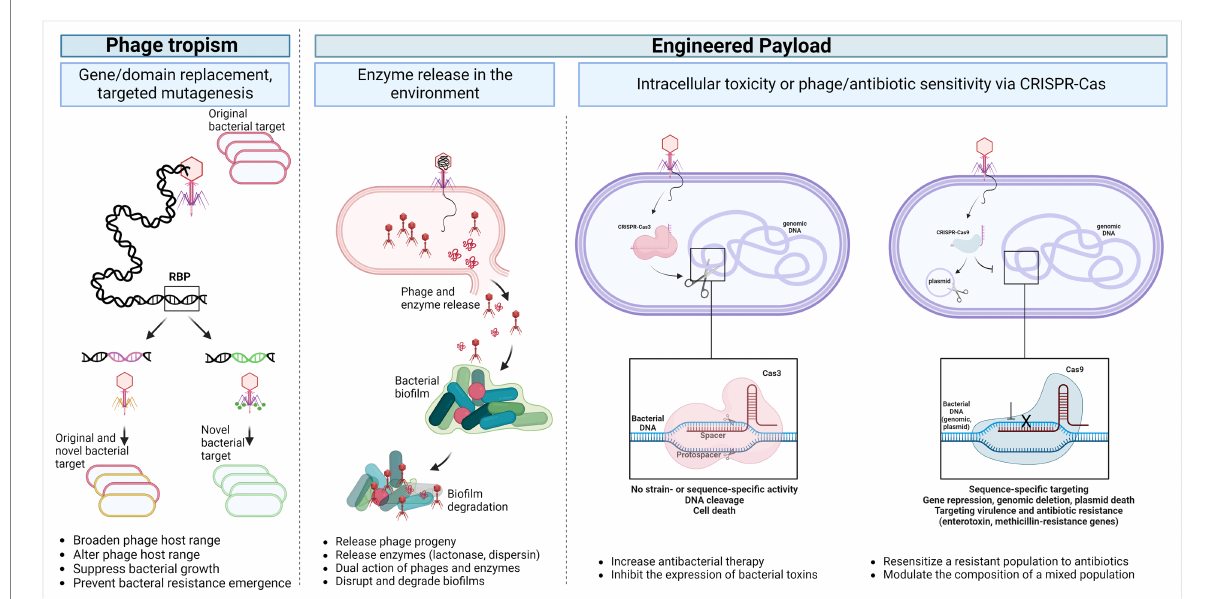
FIGURE 2 Temperate phage applications. The phage host range can be broadened, modified, or even reprogrammed into a strictly lytic phage by altering the receptor binding modules through point mutations, domain replacement or full gene replacement (Phage tropism). Additionally, genetic payloads can be engineered into the phage genome to enhance or modulate the antimicrobial activity of phages enabling the release of biofilm and capsule depolymerase, quorum-quenching enzymes, cell wall hydrolases, as well as a programmable Cas nuclease toxin. These payloads can selectively degrade biofilms and remove any resistant or virulent bacterial sub-population (Engineered payload). Abbreviations: RBP, receptor- binding protein; CRISPR, Clustered, Regularly Interspaced, Short Palindromic repeats. Created with